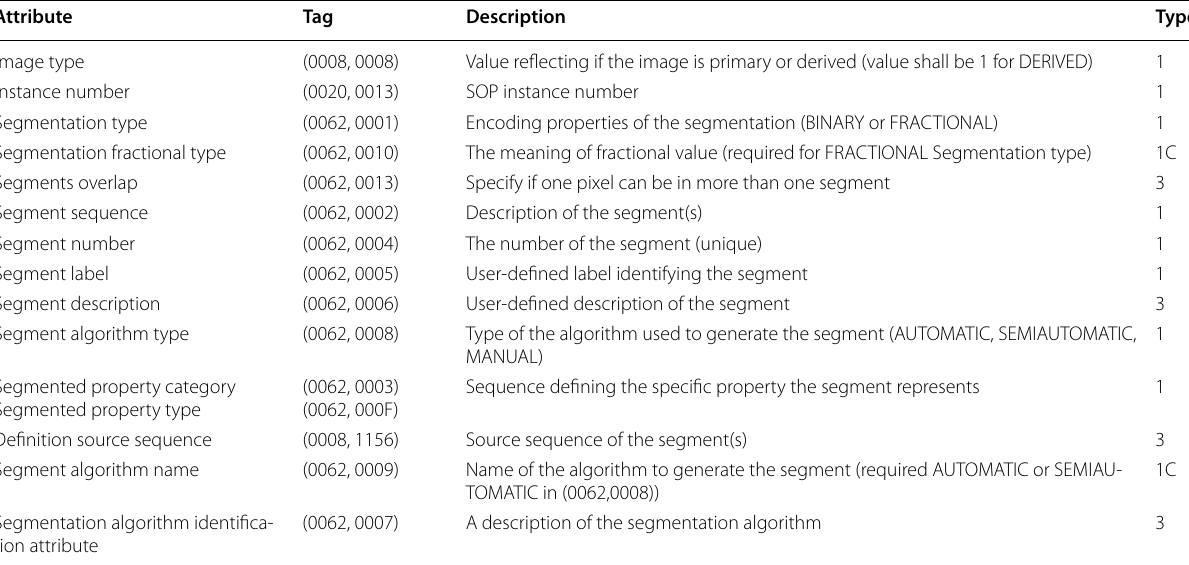
Table 2 Most pertinent/specific DICOM tags related to DICOM-SEG